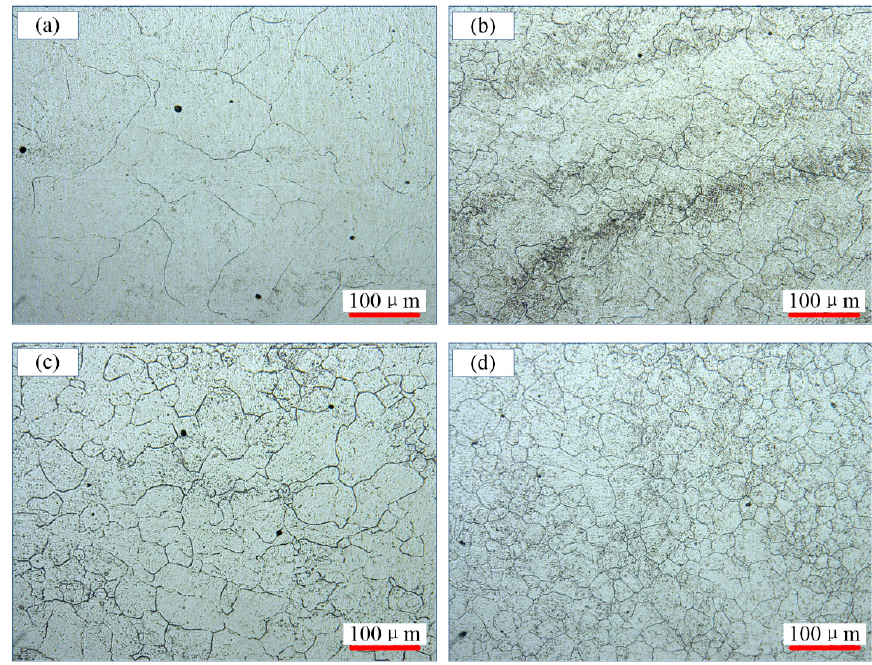
Figure 4. Microstructures of 300M steel deformed at the strain rate of: ( a ) 0.01 s − 1 ; ( b ) 0.1 s − 1 ; ( c ) 1 s − 1 ; and ( d ) 10 s − 1 .